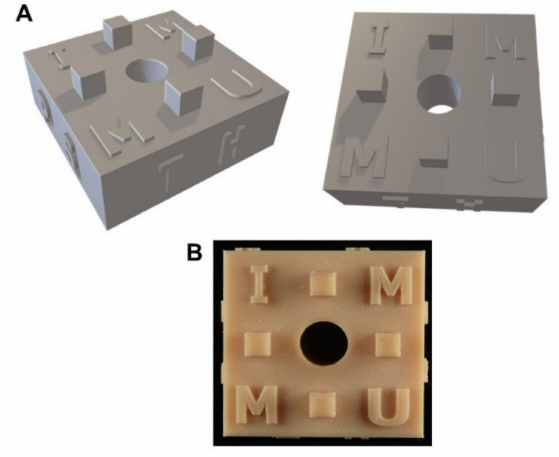
Figure 1. The 3D design of surgical guides ( A ) and printed surgical guide ( B